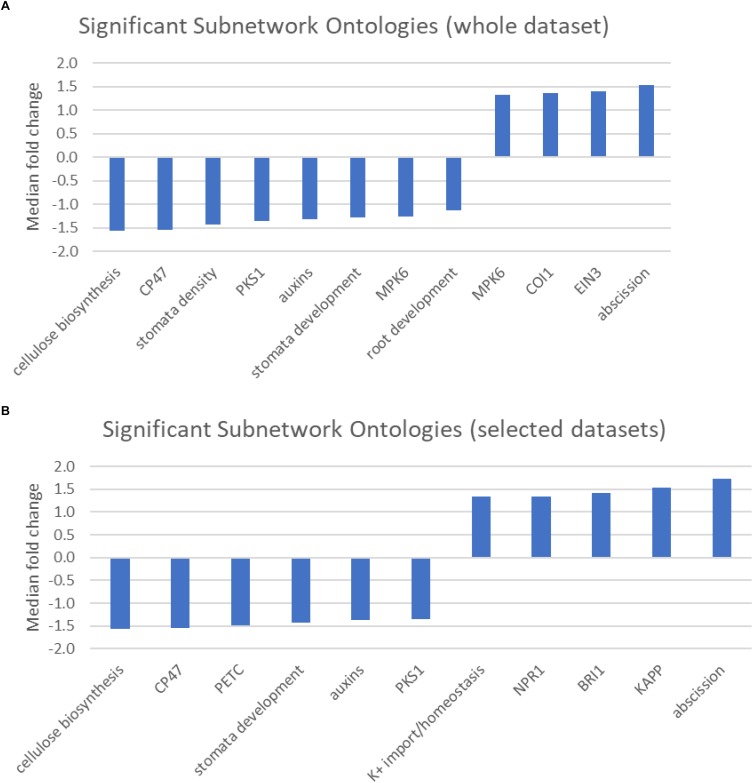
(A,B) Graphic showing the median fold change of genes associated with significantly over-represented Sub-network ontologies identified from (A) either the entire dataset, or (B) selected genes that were preferentially expressed in either the central population relative to the northern population (positive values) or genes that were preferentially expressed in the northern population (negative values).